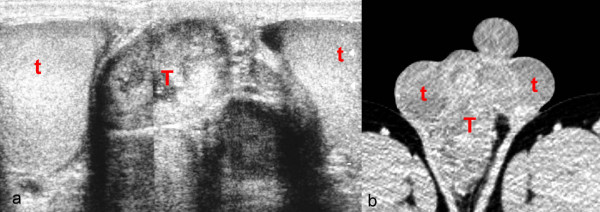
Imaging of scrotal ancient schwannoma. a) Ultrasound image and b) CT image showing an intra-scrotal and extra-testicular mass in the mid-scrotal region [Capital red T – tumour, red t – testes].